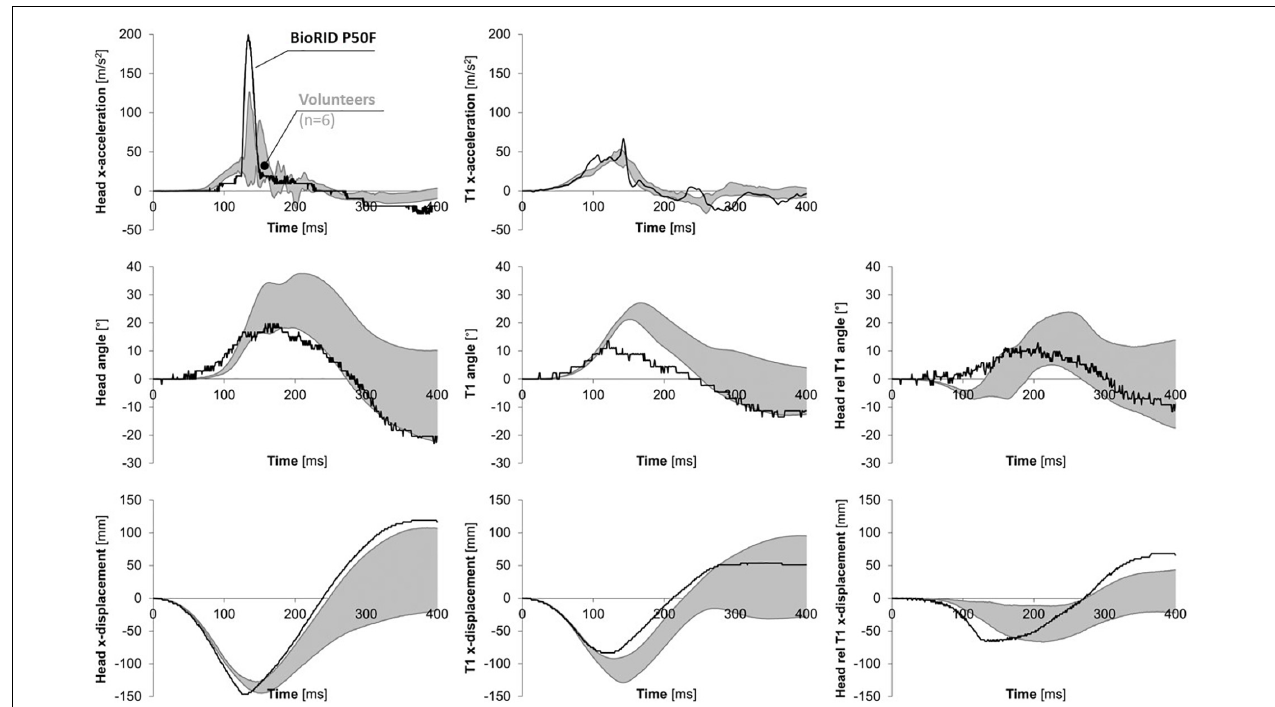
FIGURE 7 | X-acceleration of the head and T1 (NB: rotating coordinate systems); angular displacement of the head, T1 and the head relative to T1; and x-displacement relative to the sled for the head, T1 and the head relative to T1, for the 50th percentile female volunteers (gray corridor) and the BioRID P50F prototype (solid black line). The response corridors were calculated ± 1SD of the average